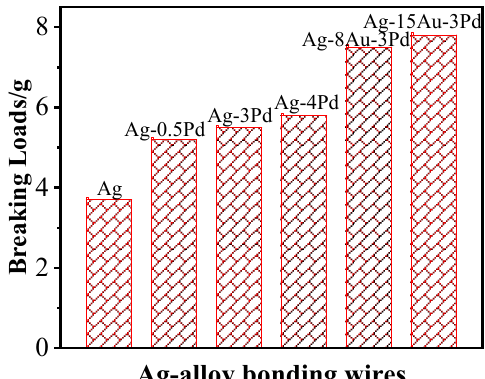
Figure 10. Fracture load of various Ag alloy wires [143]. Copyright, 2016, IEEE.